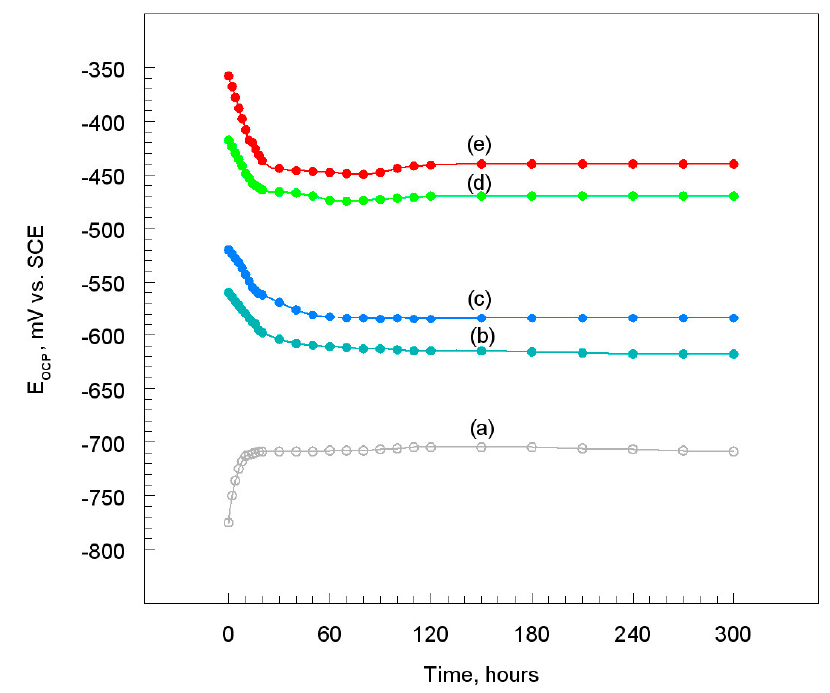
Figure 7. Evolution of the open circuit potential for the aluminum alloy and nickel coatings: ( a ) Al7075 substrate, ( b ) O60 , ( c ) A34 , ( d ) C30 , and ( e ) M28 . Solutions contained 1.2 M Cl − , pH 1.5.